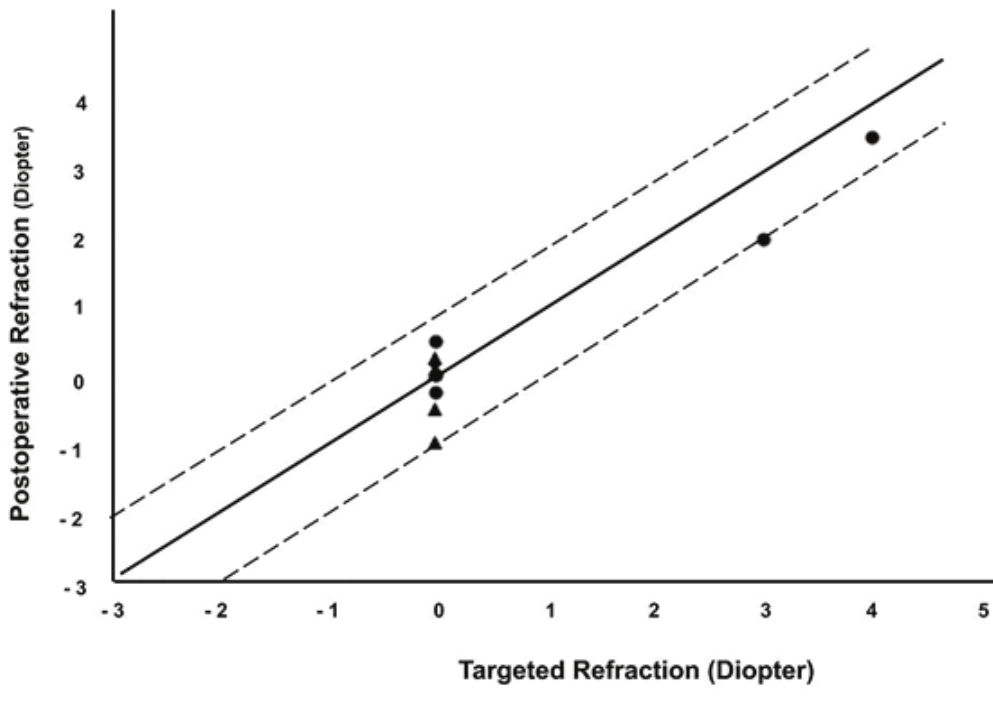
Figure 1. Target refraction plotted against achieved refraction. Triangles depict myopic patients and bullets represent hyperopic patients. All patients were within ± 1 diopters of target